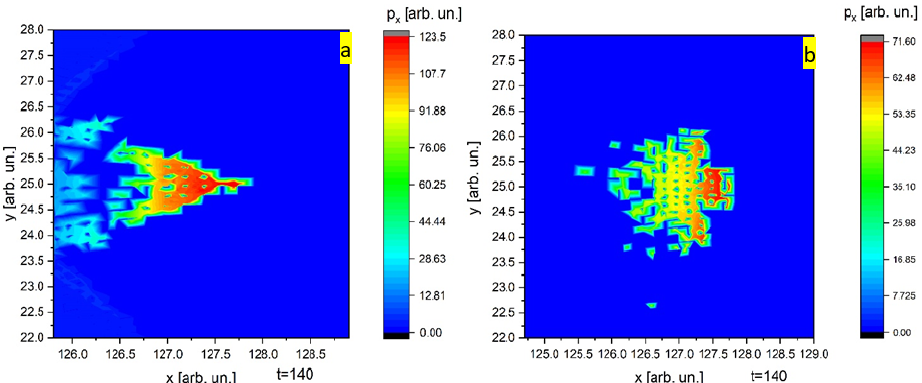
Figure 6. Distribution of the longitudinal momentum of self-injected bunch in inhomogeneous ( a ) and homogeneous ( b ) plasma t = 140 T 0 . p x is normalized to m e c .